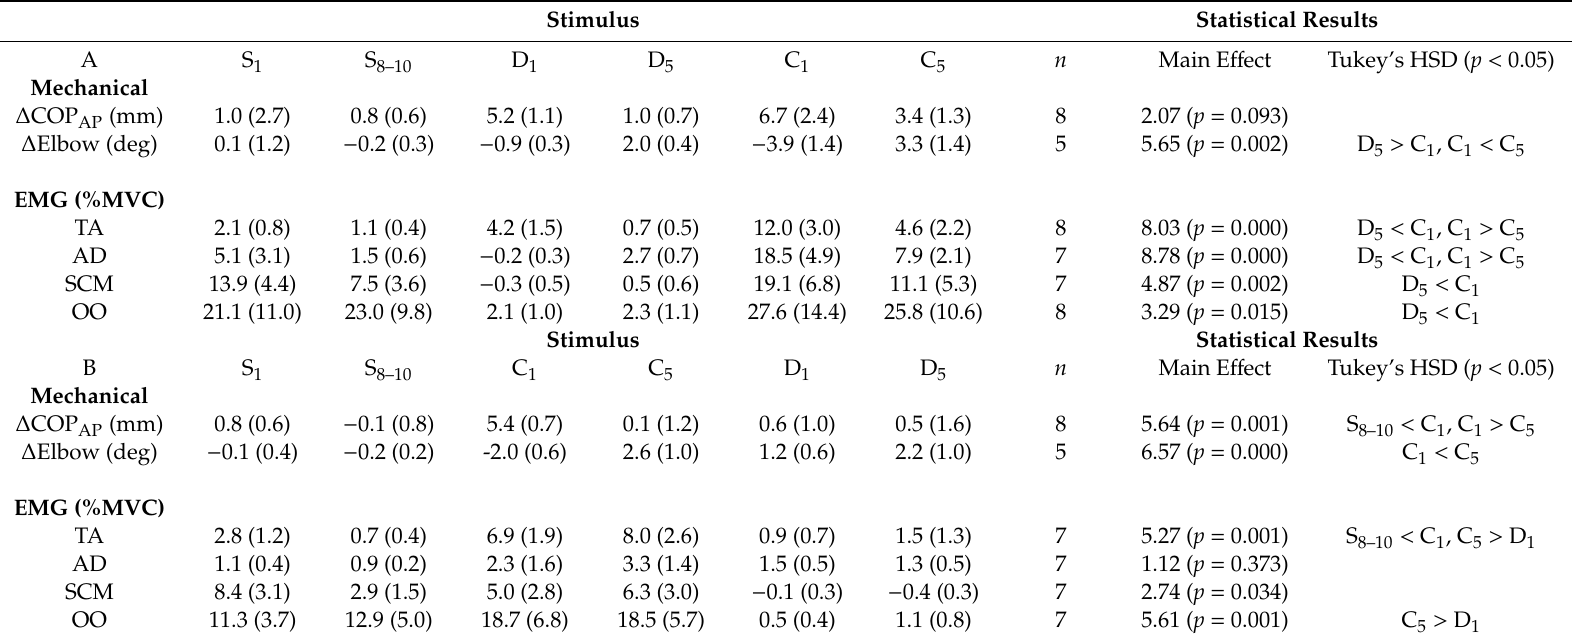
Table 3. Change in COP AP position and elbow angle, and normalized muscle response